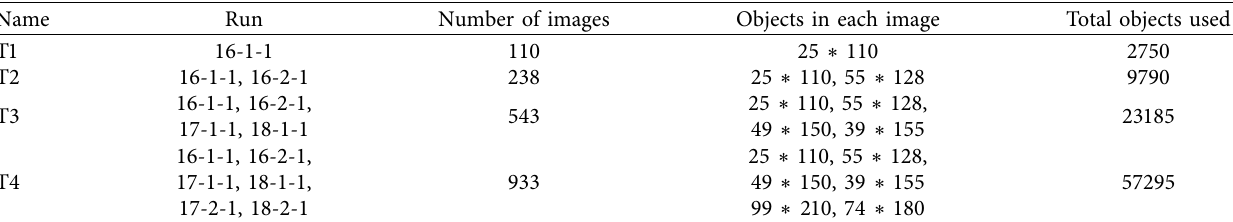
Figure 3: Some typical images of our pedestrian flow experiments. (a) ρ � 2 . 9ped/m 2 , 145 objects, in 17-3-1; (b) ρ � 4 . 7ped/m 2 , 175 objects, in 18-5-1; (c) ρ � 7 . 0ped/m 2 , 357 objects, in 17-7-1; (d) ρ � 9 . 0ped/m 2 , 234 objects, in 16-9-1. Table 1: The information of training